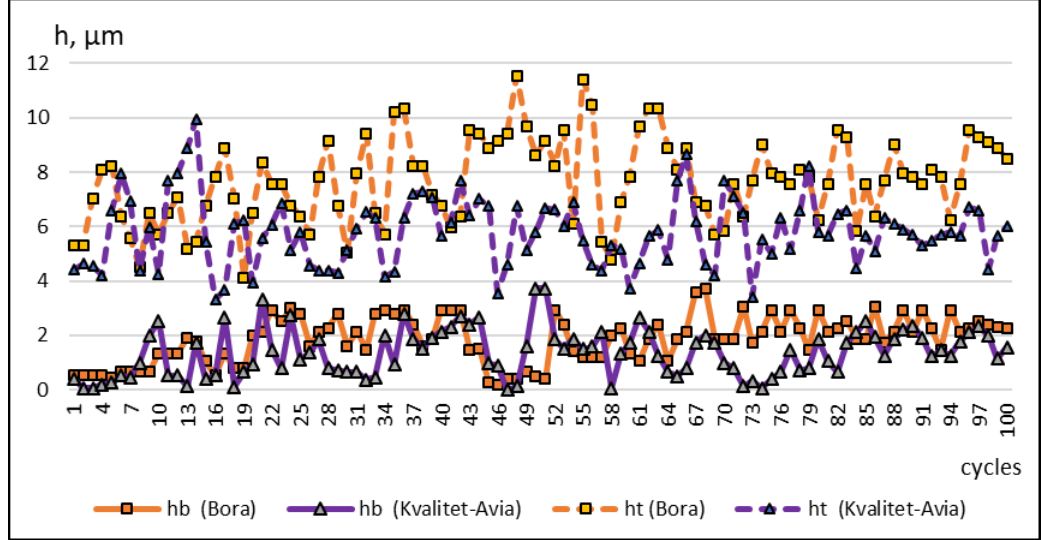
Fig. 3. Kinetics of change in the thickness of the boundary adsorption layers (h b ) and the total thickness of the lubricating layer (h t ) in the course of